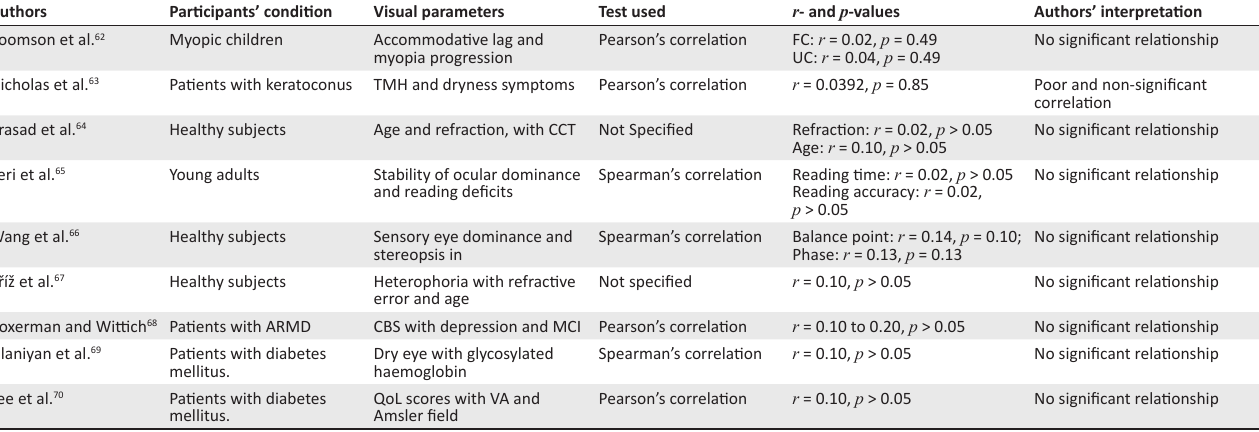
TABLE 4: Studies that investigated ophthalmic data using both Pearson’s and Spearman’s correlation coefficient tests and did not find relationships.